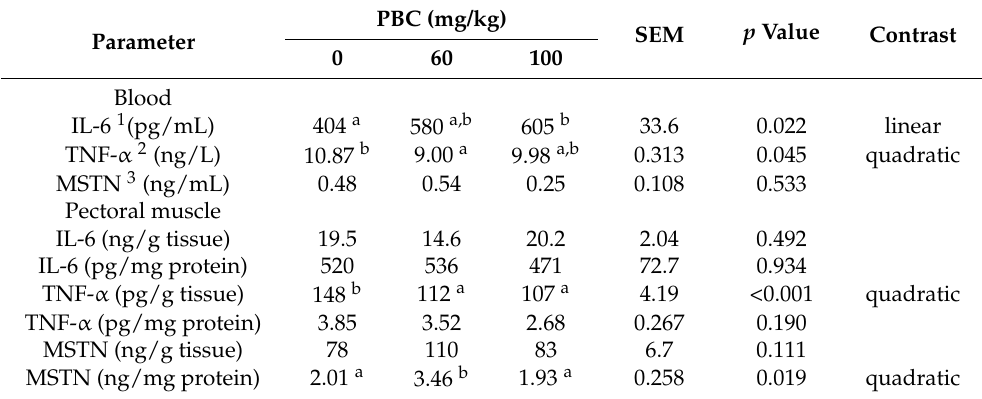
Table 5. Myokine concentrations in blood and pectoral muscle of broiler chickens fed diets supple- mented with 60 and 100 mg/kg